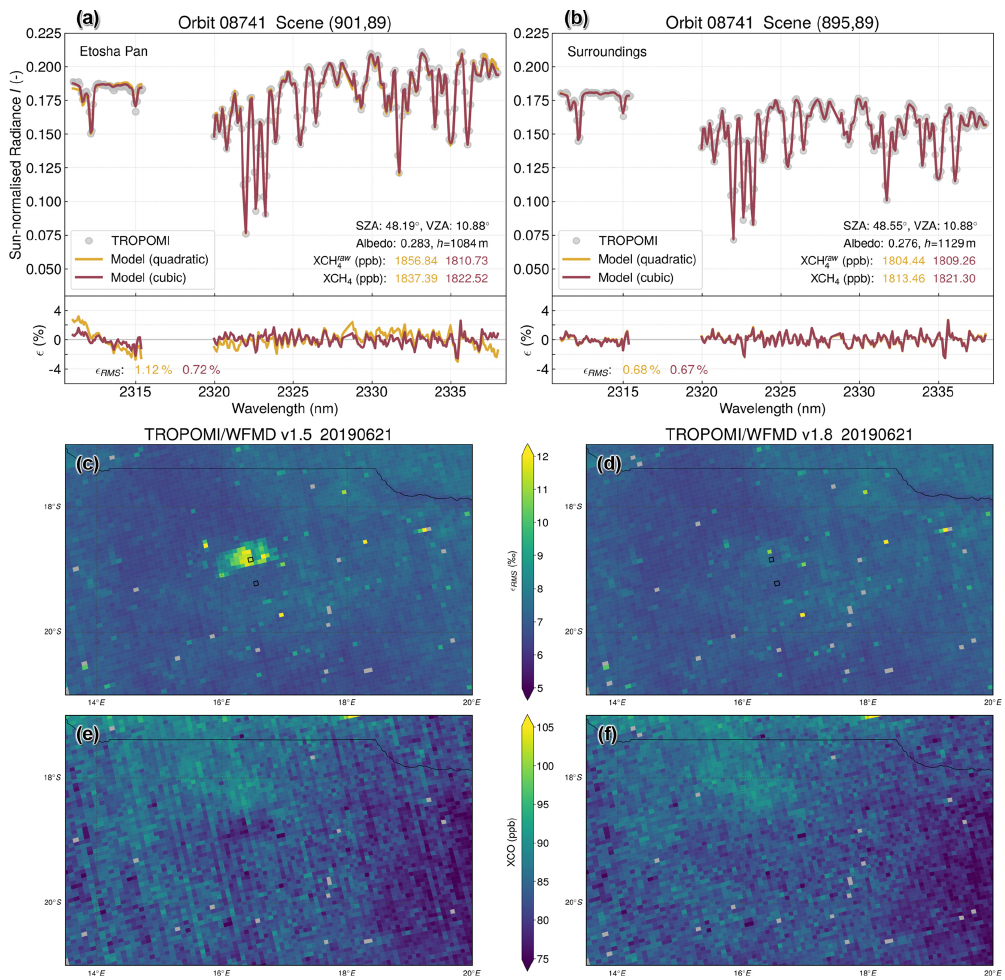
Figure 5. Example fits for two scenes (a) inside and (b) outside the Etosha Pan. The spectral TROPOMI measurements are shown as grey dots, and the respective models (and fit residuals) are shown in yellow and red for using a quadratic or cubic polynomial in the fitting procedure. Also shown are maps for a single satellite overpass of (c–d) the root mean square of the fit residuals (with the two example scenes being highlighted by a black border) and (e–f) XCO. The maps (d, f) associated with a cubic polynomial (v1.8) are much more homogeneous and the extent of the pan is no longer visible. Please note that for v1.8 XCO an additional destriping algorithm has been applied (see Sect.